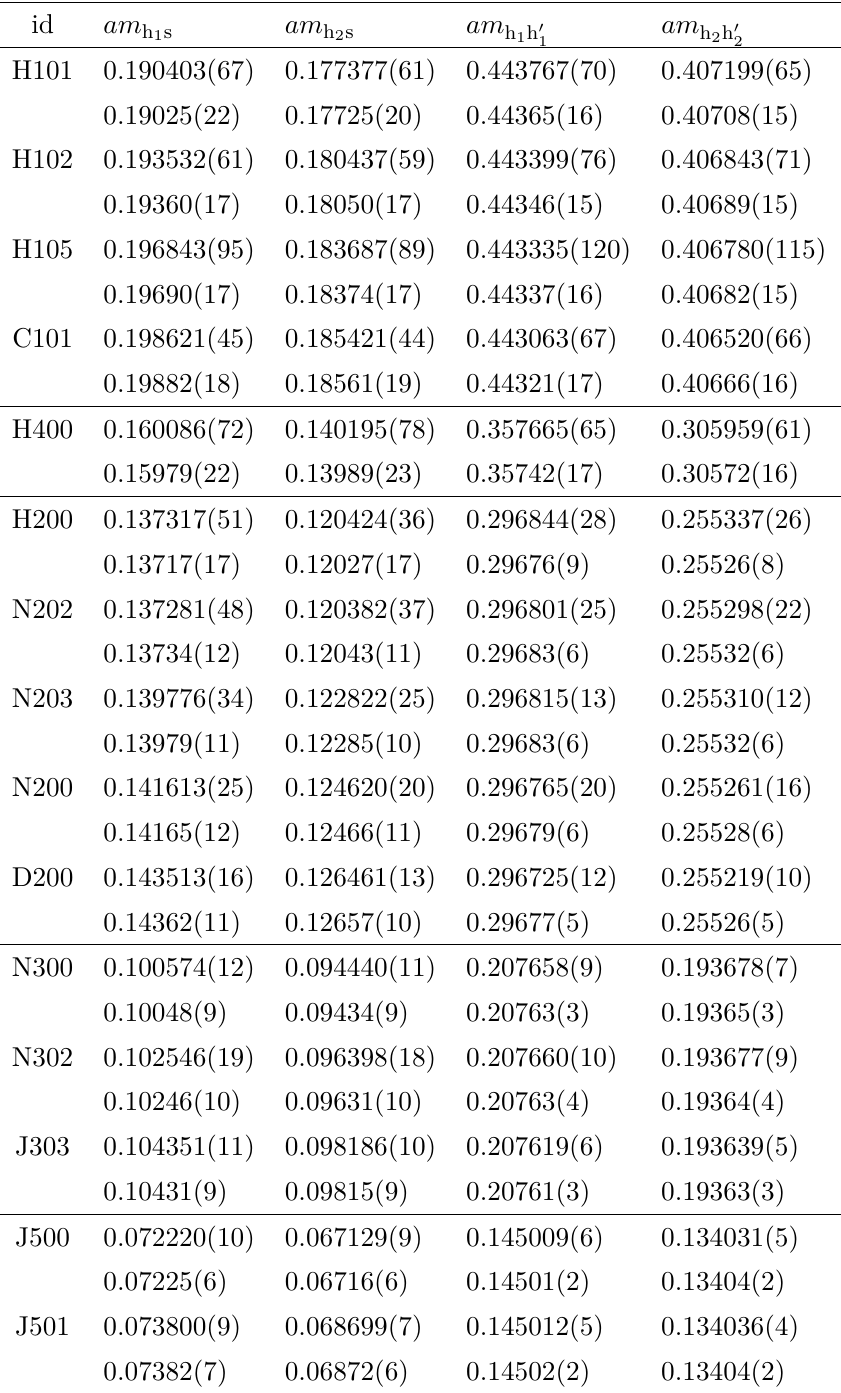
Table 7 . Overview of the results for heavy-strange and heavy-heavy PCAC quark masses from standard lattice derivatives, referring to the heavy quark hopping parameter choices given in table 2. As before, for every ensemble we list the numbers before the shift in the rows with labels and the corresponding ones after the shift to φ phys in the rows without labels. Analogous results from 4 improved lattice derivatives are collected in table